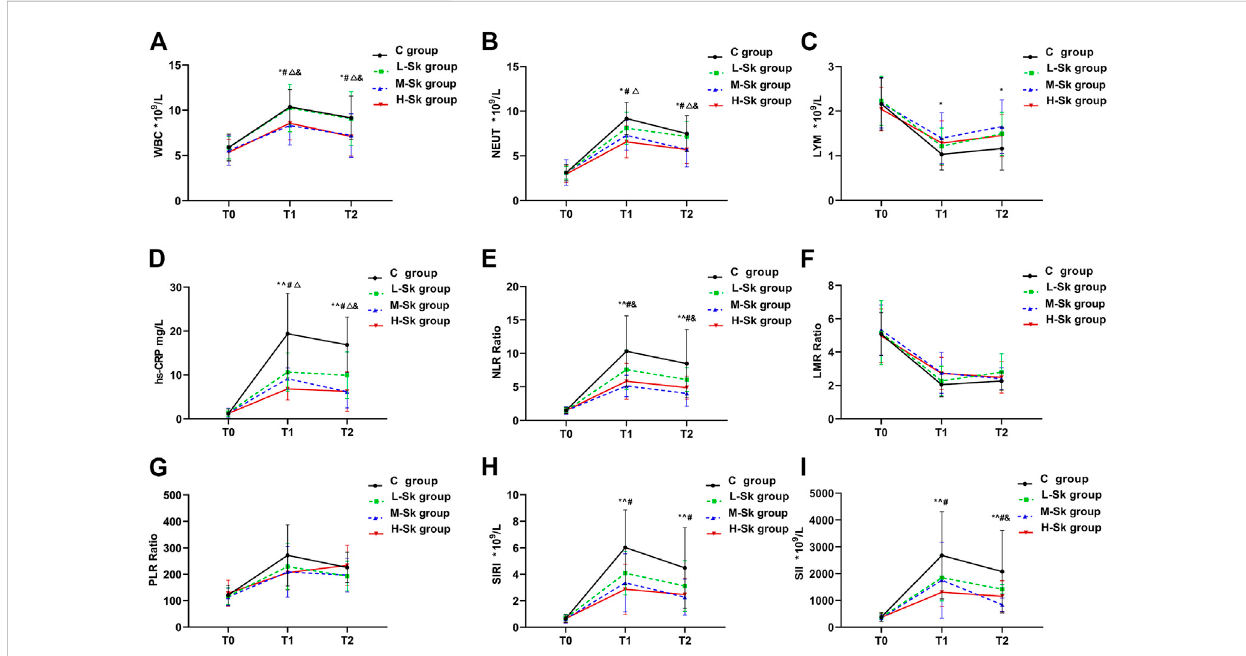
FIGURE 3 Comparison of the systemic in fl ammatory responses among the four groups. The system in fl ammatory variables include WBC (A) , NEUT (B) , LYM (C) , hs-CRP (D) , NLR (E) , LMR (F) , PLR (G) , SIRI (H) , and SII (I) . Values represent the estimated means from linear mixed models with the standard error, analyzedusingANOVAforrepeatedmeasures.T0,beforeanesthesia;T1,attheendofthesurgery;T2,24 hafterthesurgery;Cgroup,controlgroup;L-Sk group, low-dosage S-ketamine group; M-Sk group, middle-dosage S-ketamine group; H-Sk group, high-dosage S-ketamine group. WBC, white blood cells; NEUT, neutrophils; LYM, lymphocytes; NLR, neutrophil-to-lymphocyte ratio; LMR, lymphocyte-to-monocyte ratio; PLR, platelets-to- lymphocyte ratio; SIRI, systemic in fl ammation response index; SII, systemic immune-in fl ammation index. ^ p < 0.05, the L-Sk vs C groups at the corresponding time point. * p < 0.05, the M-Sk vs C groups at the corresponding time point. # p < 0.05, the H-Sk vs C groups at the corresponding time point. △ p < 0.05, the H-Sk vs L-Sk groups at the corresponding time point. & p < 0.05, the M-Sk vs L-Sk groups at the corresponding time point. ▲ p < 0.05, the H-Sk vs M-Sk groups at the corresponding time